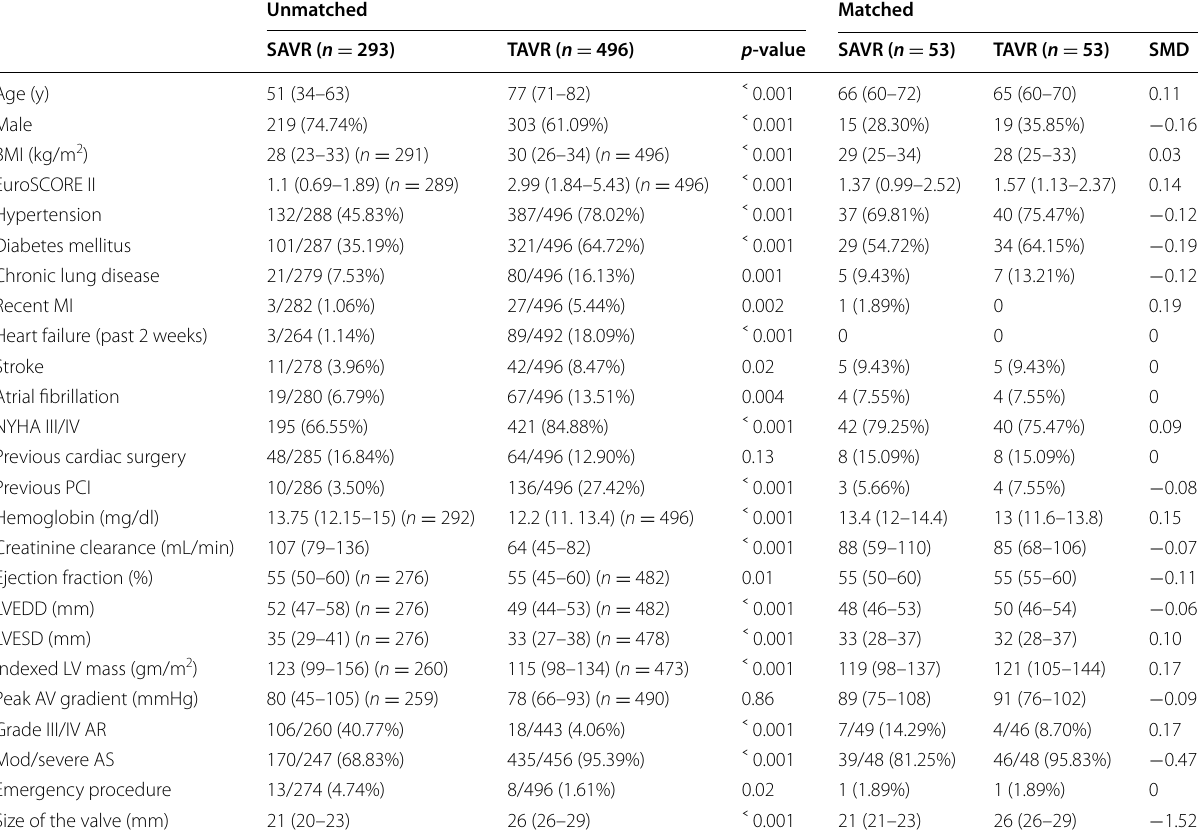
Table 1 Comparison of the preprocedural data between patients who had surgical vs. transcatheter aortic valve replacement before and after matching ( SAVR , surgical aortic valve replacement; TAVR , transcatheter aortic valve replacement)